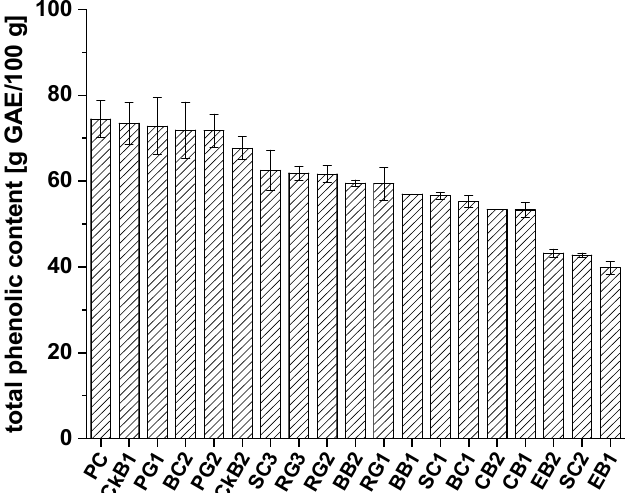
Figure 1. Total phenolic content of different extracts from chokeberry (CkB), cranberry (CB), pomegranate (PG), blueberry (BB), elderberry (EB), red grape (RG), sour cherry (SC), and black currant (BC) defined as gallic acid equivalents (g GAE/100g ± SD), compared to the positive control (PC), ascorbic acid.